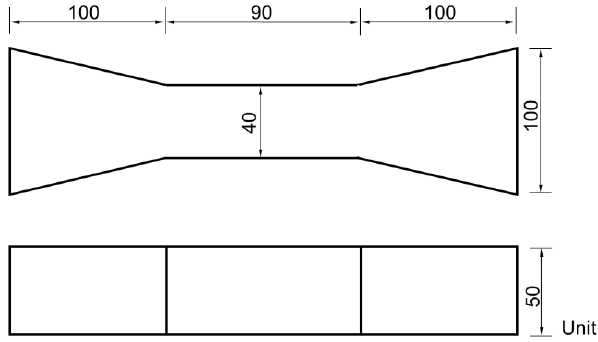
Figure 3 . Schematic diagram of the size of the tensile specimen. Figure 3. Schematic diagram of the size of the tensile specimen.